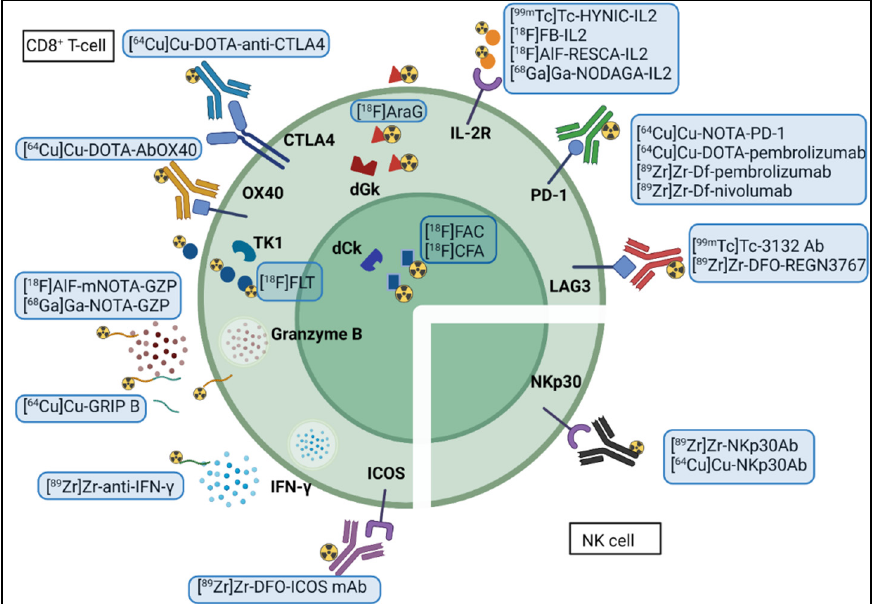
Figure 2. Tracers that image cytotoxic immune cells’ functional state. Created with BioRen-